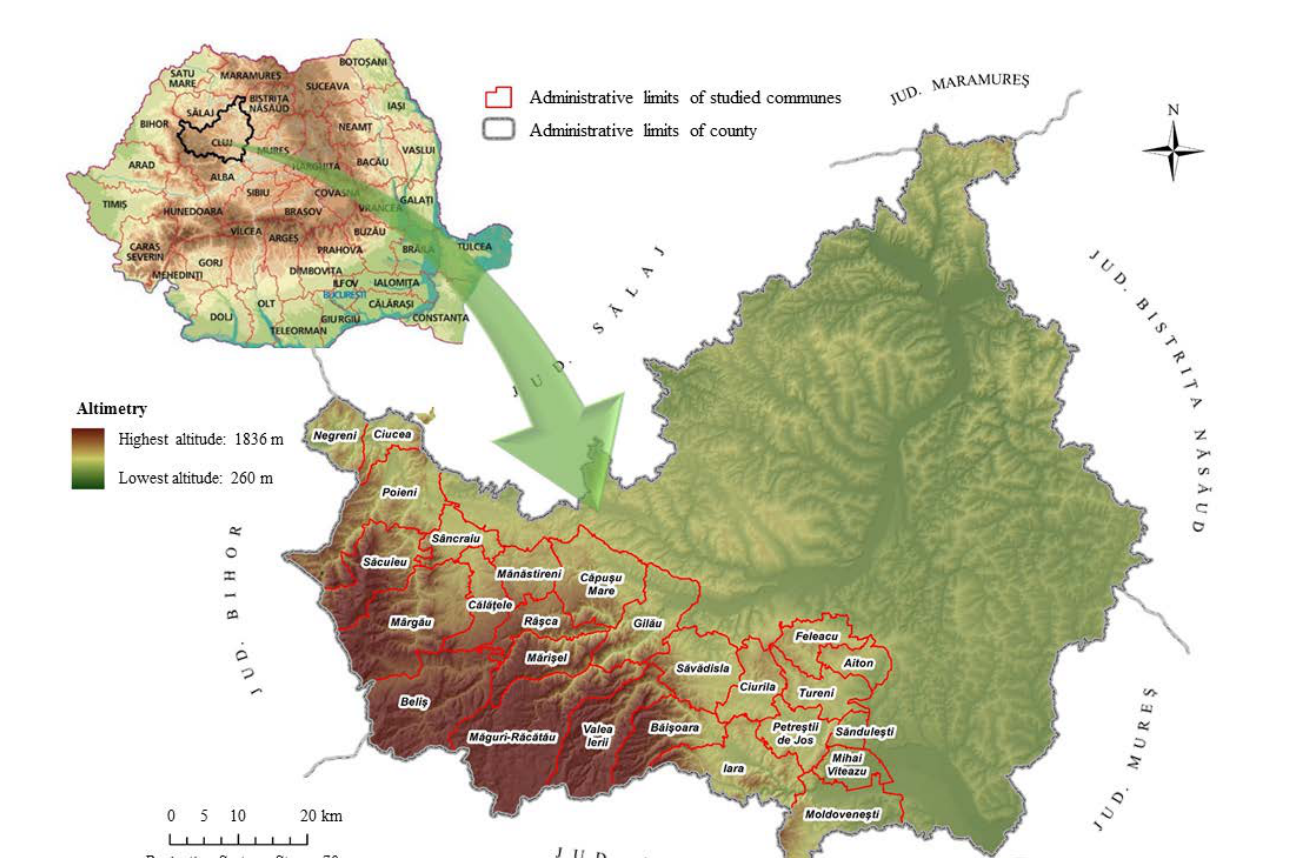
Figure 2: Map of the area under